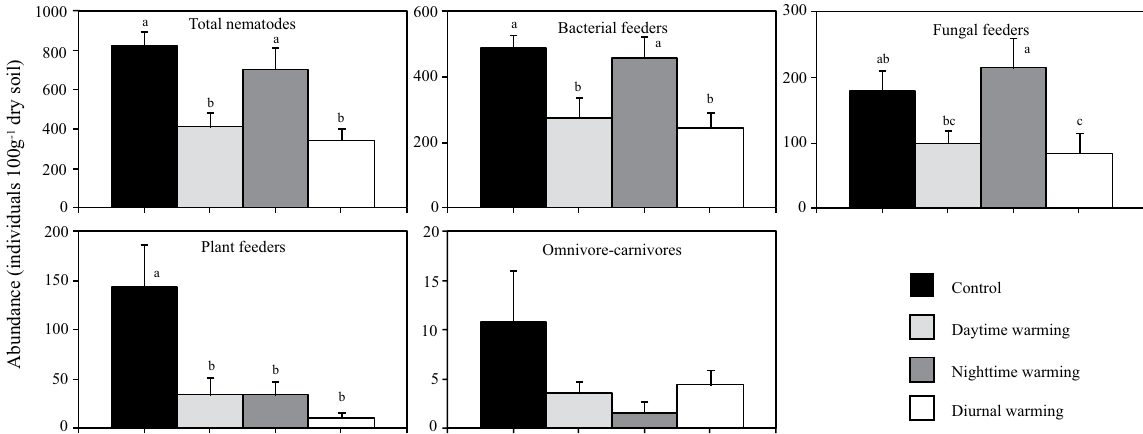
Figure 1. Abundance of the total nematodes (ANOVA, df = 3, F = 9.3, p = 0.00), bacterial feeders (F = 6.1, p = 0.01), fungal feeders (F = 3.9, p = 0.02), plant feeders (F = 6.0, p = 0.01) and omnivore-carnivores (F = 1.5, p = 0.26) in control (C), daytime warming (DW), night-time warming (NW) and diurnal warming (24 hW). Bars with different letter (a–c) are significant difference based on LSD. Error bars represent standard error (SE).